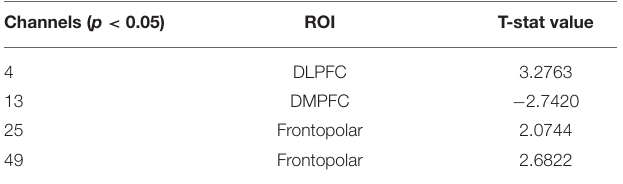
TABLE 3 | Oxyhemoglobin contrast results between GLM output of low transparency and high transparency conditions (T Low R Low + T low R High )-(T High R Low +T High R High ). Channels ( p < 0.05)